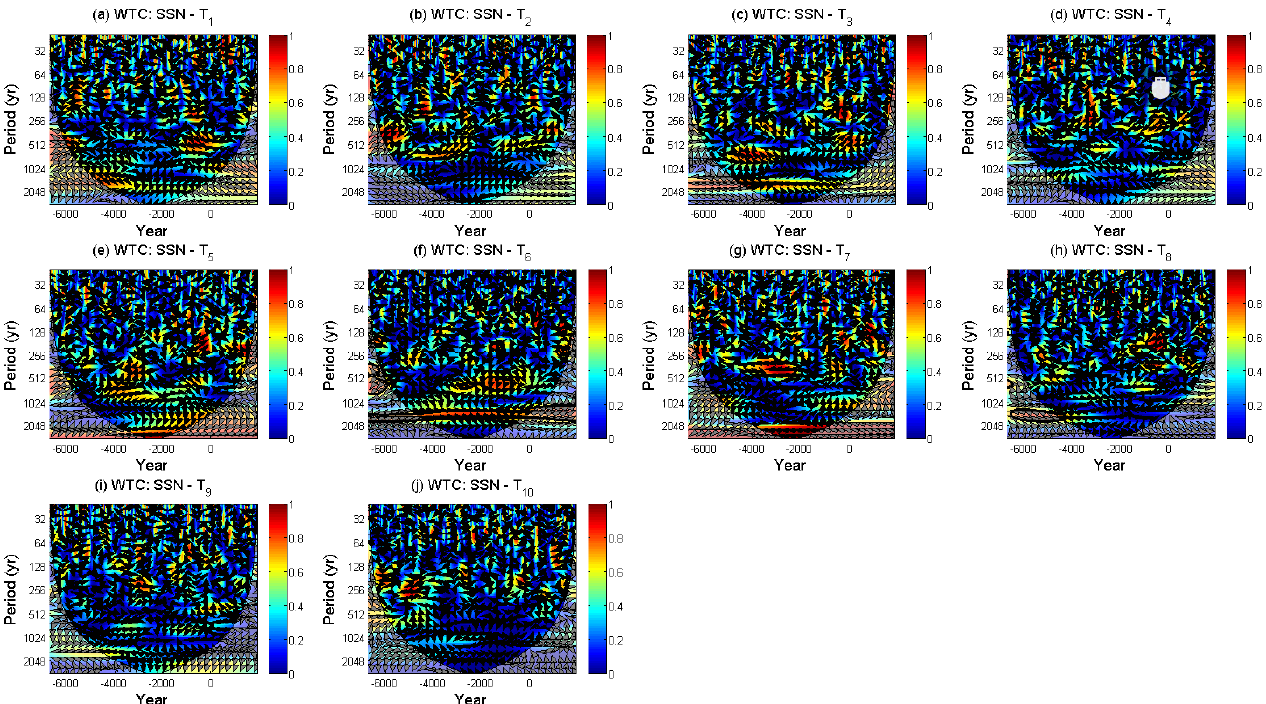
Figure 3. Cross-wavelet analyses between SSN and temperatures. The red regions enclosed by thick black lines denote their confidence levels higher than 95% against red noise. The light black curve denotes the “cone of influence” (COI). We adopted the global wavelet coherence C g ( p ) and angle strength S θ ( p ) to quanti- tatively estimate the cross-wavelet correlations between SSN and temperatures. They are parameters integrated along time at fixed period ( p ) in the wavelet coherence output by the WTC tool, and their detailed definitions can be found in [16]. Here, C g reflects an overall correlation between two series at a fixed p , and S θ depicts how strongly the phase angles between series keep stable. C g = 1 means absolute correlation, and C g = 0 means absolute non-correlation; S θ = 1 indicates absolute “phase-locked”, and S θ = 0 indicates absolute “non-phase-locked.” The combination of C g and S θ can reveal whether the co-variances of two analyzed series are strong and stable. Figure 4 shows the variations of C g and S θ between SSN and temperatures along p outside the COI (cone of influence). The vertical shaded region denotes the millennial cyclicity, i.e., 900 years to 1100 years. We can see that both curves ( C g and S θ ) have peaks almost simultaneously at the millennial periodicity for T 1 , T 4 , T 5 , T 7 and T 10 . For example, S θ ,peak (1ky) = 0.76 and C g,peak (1ky) = 0.44 for T 1 . For the other temperatures (T 2 , T 3 , T 6 , T 8 , T 9 ), their angle strengths present a peak at this millennial cycle, but the peak of their wavelet coherence is not so evident as those in angle strengths, meaning that only phas- es were securely locked at this millennial cycle. In general, this figure demonstrates that the wavelet coherences between SSN and temperatures kept strong and stable at the 1000-year cyclicity, relative to other cyclicities.